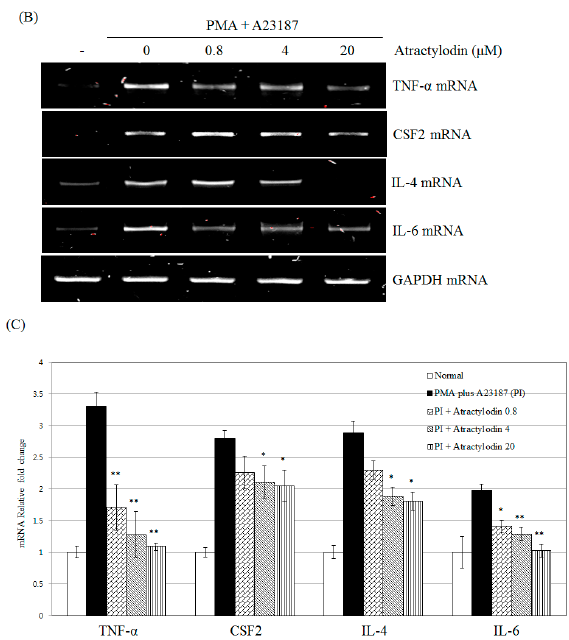
Figure 4. Effect of atractylodin on the release of IL-6 ( A ) and the expression of TNF- α , CSF2, IL-4, and IL-6 mRNA ( B , C ) in PMA plus A23187-stimulated HMC-1 and cell was treated with the indicated concentrations of atractylodin for 0.5 h prior to being incubated with PMA (50 nM) plus A23187 (1 µ M) for 24 h and detected by ELISA, RT-PCR, and real-time RT-PCR, analysis as described in Materials and Methods. Monte10: montelukast 10 µ M. Statistical significance: * p < 0.05 as compared to the PMA plus A23187 treated group. ** p < 0.005 as compared to the PMA plus A23187 treated group. Values shown are the mean ± S.E. of duplicate determinations from three separate experiments.